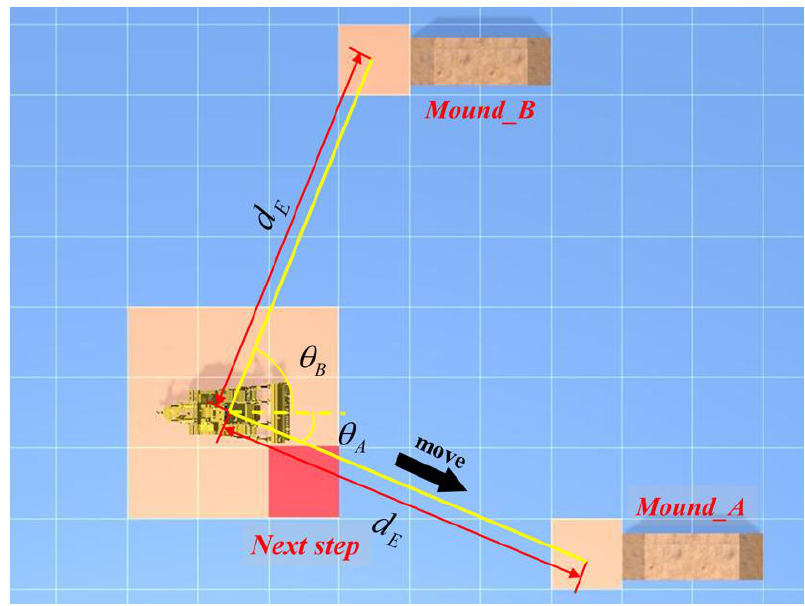
Figure 7. Feedback control of bulldozer by OODA decision module.